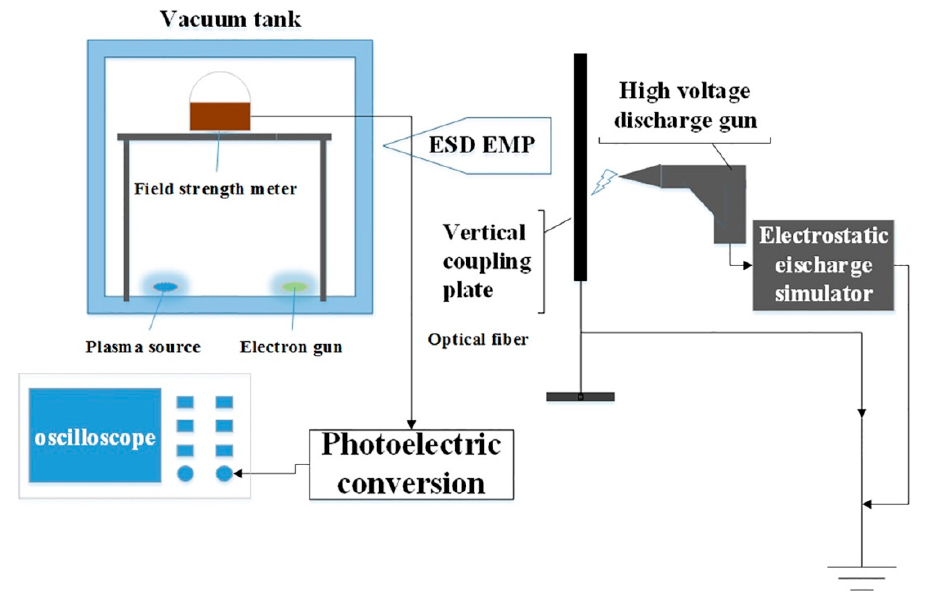
Figure 5. Pulse electric field test system. Table 1. Peak values of ESD EMP produced by different discharge gun voltages.